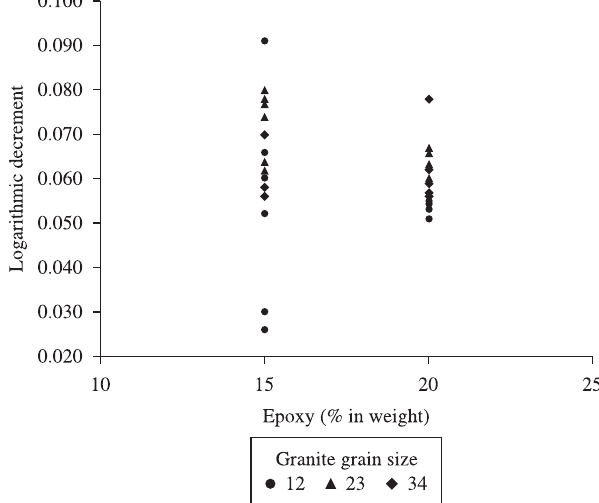
Figure 9. Logarithmic decrement of the granite-epoxy samples.